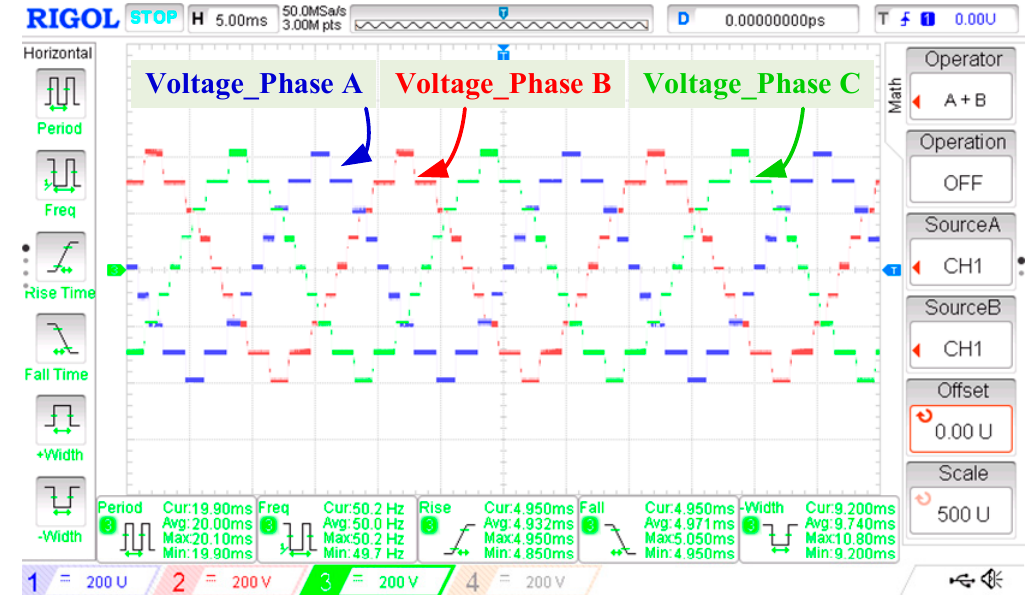
Figure 15. HIL result: three-phase voltages of nine-level SCMLI.